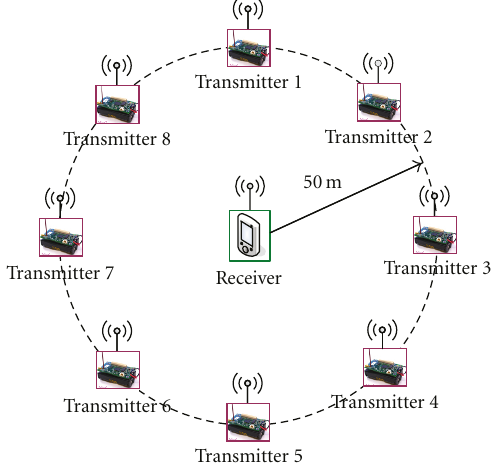
Figure 2: Simulated network